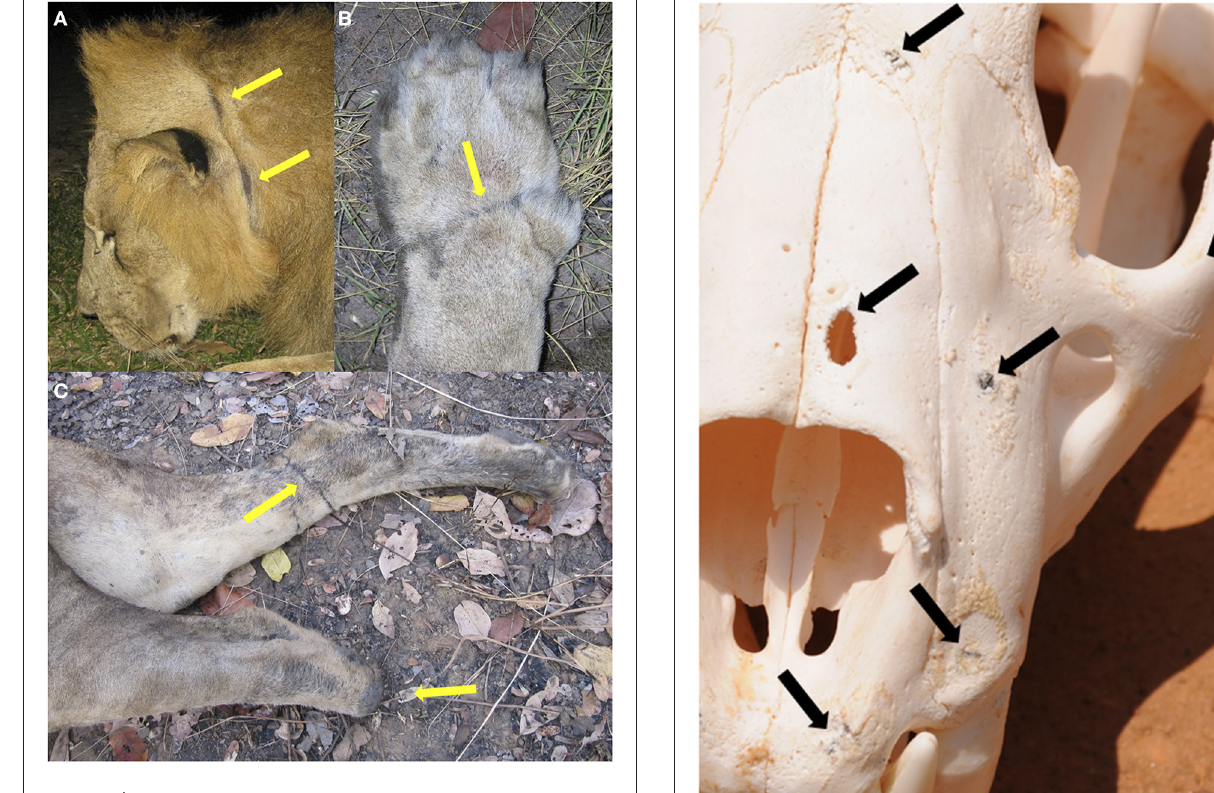
FIGURE 3 | Old scars (arrows) caused by wire snares (A) encircling a lion’s neck and (B) a lion’s left front foot. (C) Lion with healed stump of left hind foot lost to a snare and snare scar encircling right hind leg above the hock.